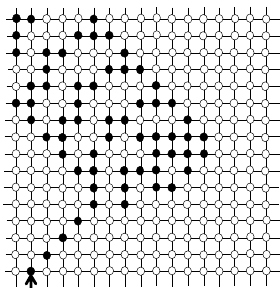
Figure 4. The ant starting from the arrow proceeds as RLRLRLRLRL, and then starts repeating 104 steps forever, forming the famous diagonal highway going in a southeast